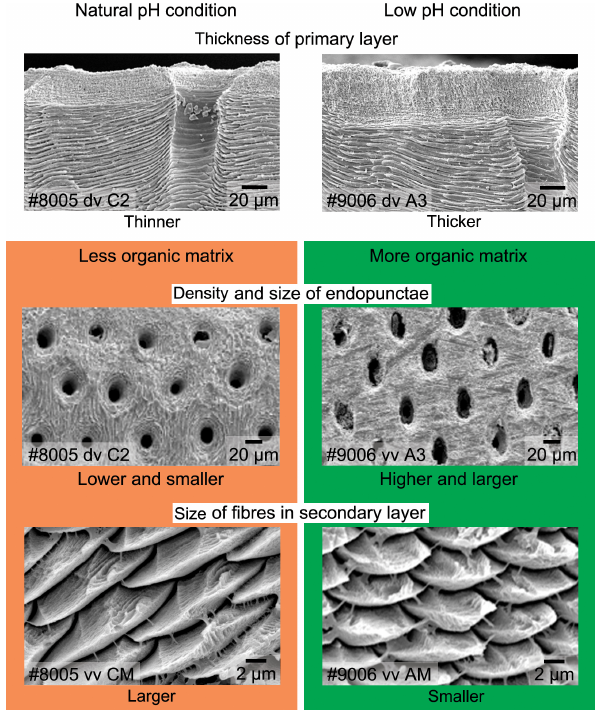
Figure 11. Relationship between the microstructure and the organic components of calcified shells of brachiopods. Position informa- tion: see Figs. 6 and 7; dv: dorsal valve; vv: ventral valve; CM: central middle part; AM: anterior middle part.